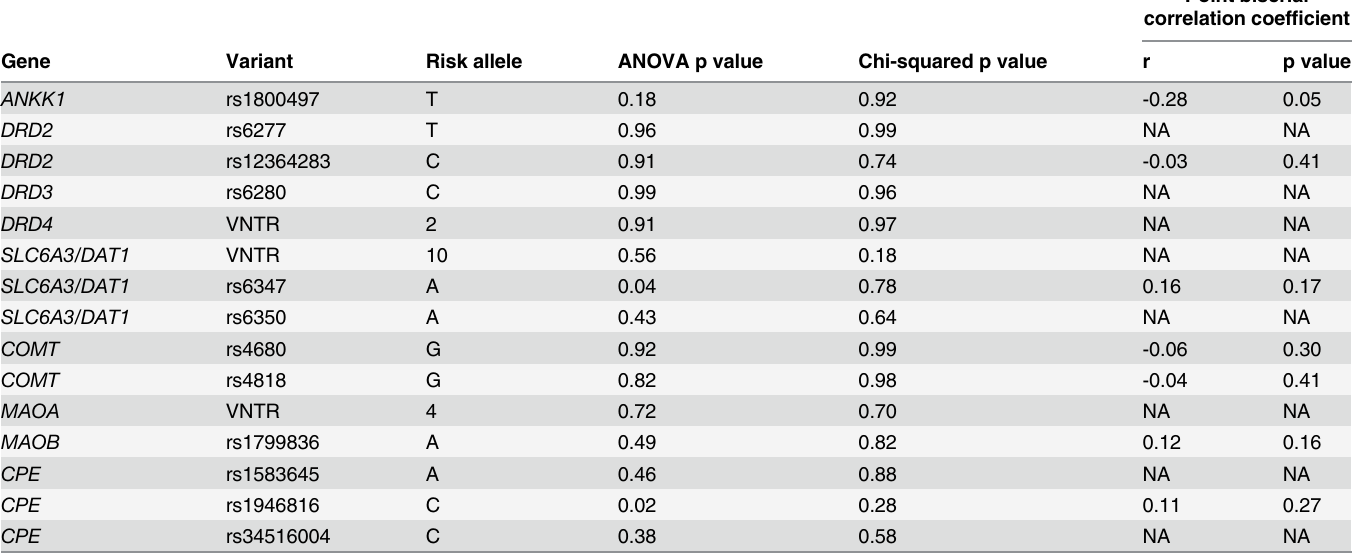
Table 2. Dose dependent comparison of genotype with percent weight